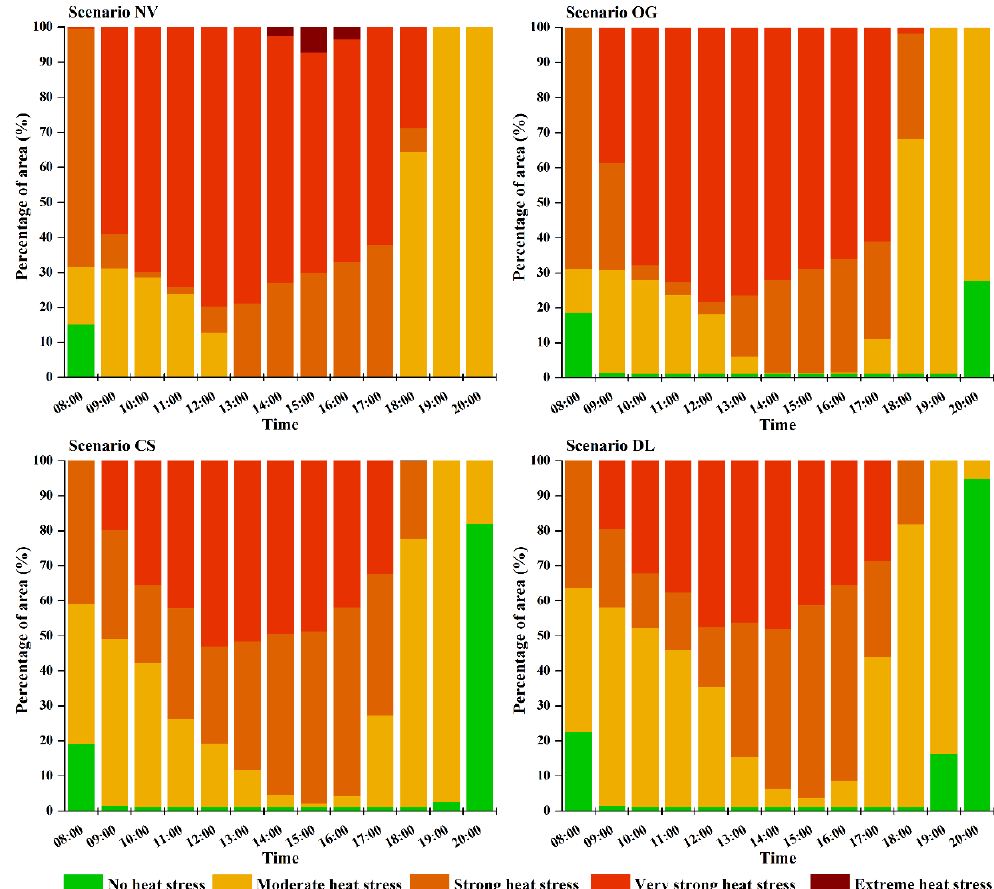
Figure 10. Variation of area experiencing different heat stress levels under 4 developed greening scenarios. NV, OG, CS and DL are short for No Vegetation, Only Grass, Current Situation and Double LAD, respectively.